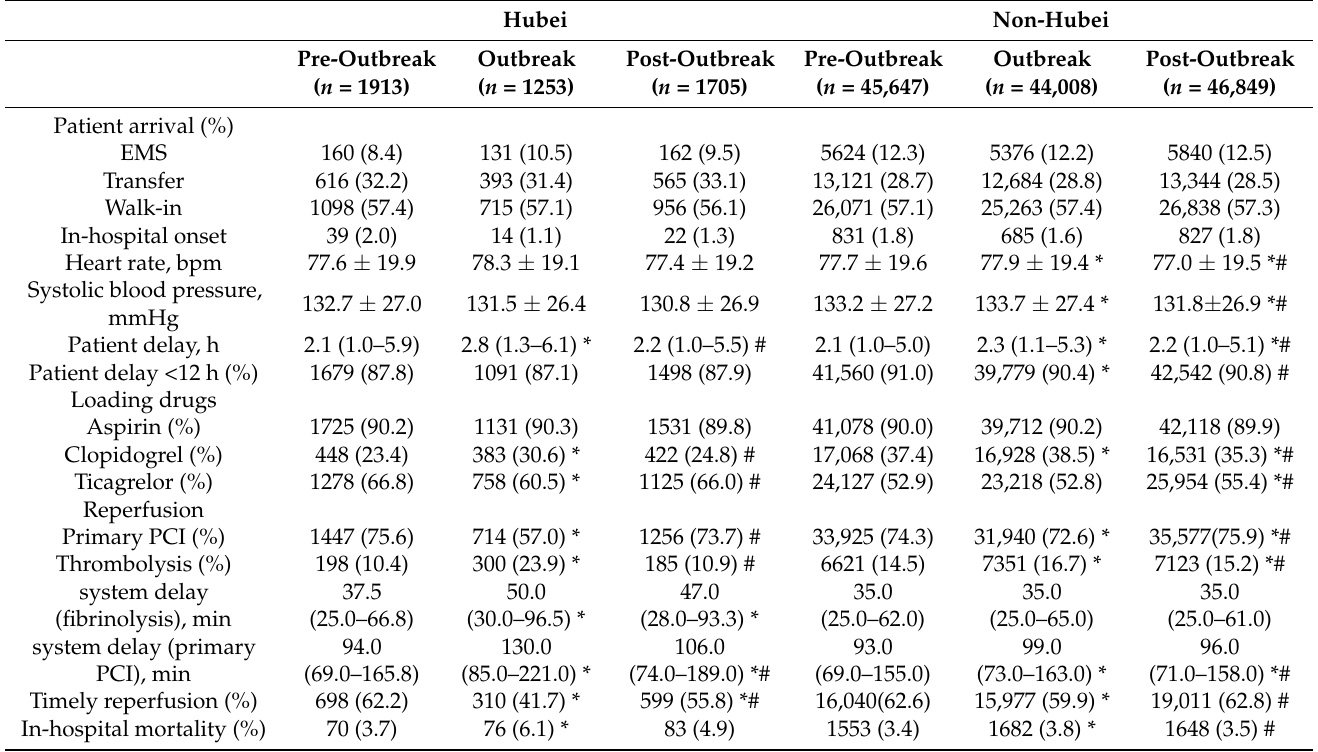
Table 2. Patterns of reperfusion strategy and outcomes.